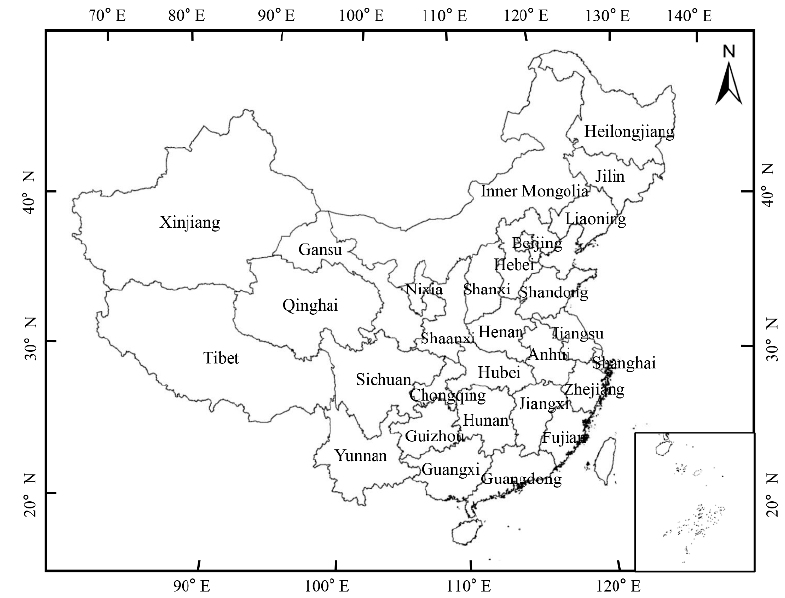
Figure 1. Locations of the study area.